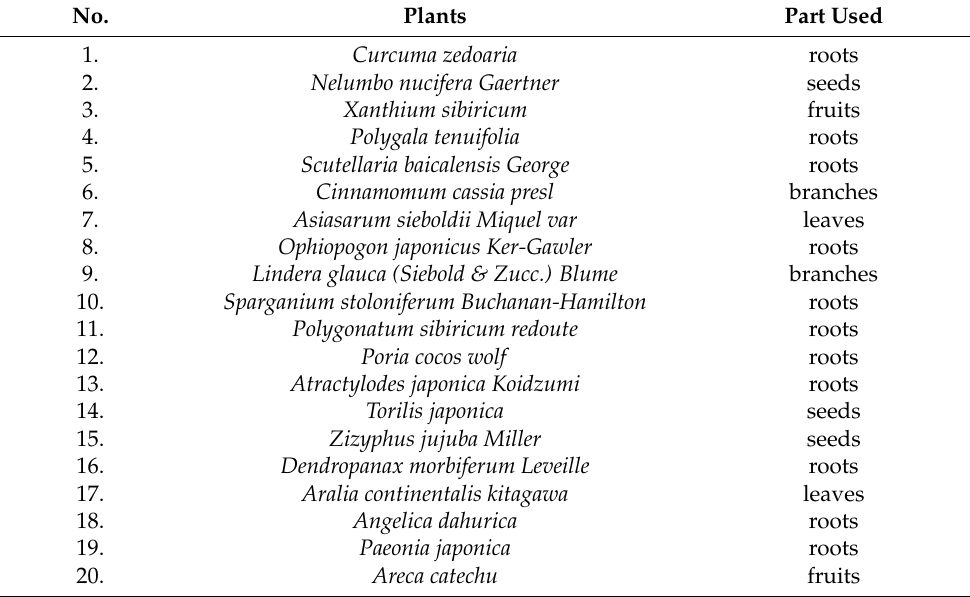
Table 1. List of medicinal plants used for